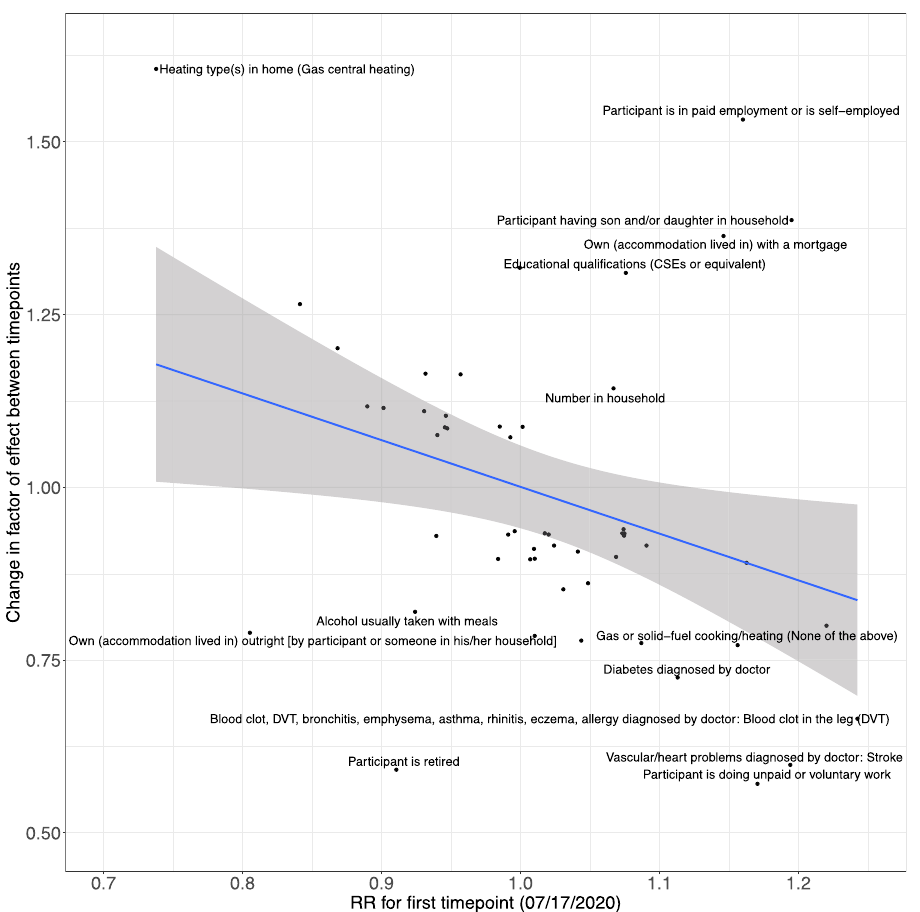
Fig. 4 Change in relative risk between participants sampled in 2/02/2021 and 7/17/2020 vs. relative risk for participants sampled in July 2020 (x-axis). Scatterplot of associations with FDR < 0.1 signi fi cant interaction effects between risk ratios (RR) for fi rst time point (07/17/2020) and change in factor of effect between time points. Exposures that signi fi cantly deviate from the overall negative linear trend are labelled. The blue line on the scatterplot represents a linear regression line and the grey shading around it represents the 95% con fi dence